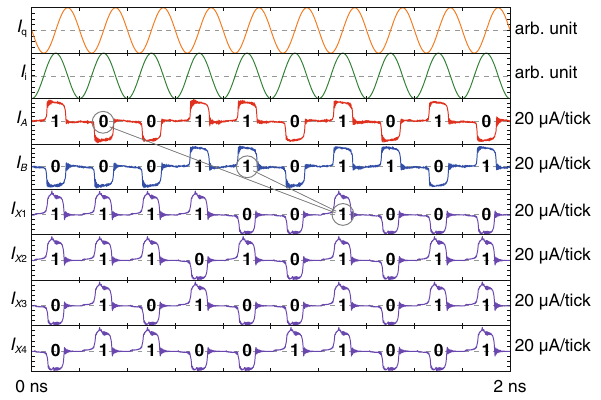
Figure 4. Simulation waveforms of the AQFP-based XSR circuit for f = 5 GHz. Four random bitstreams ( I X 1 through I X 4 ) are generated from two random bitstreams ( I A and I B